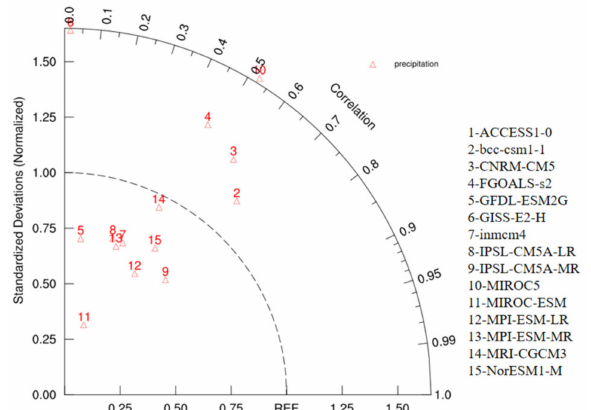
Figure 4. The Taylor diagram of precipitation in the flood season from 2006 to